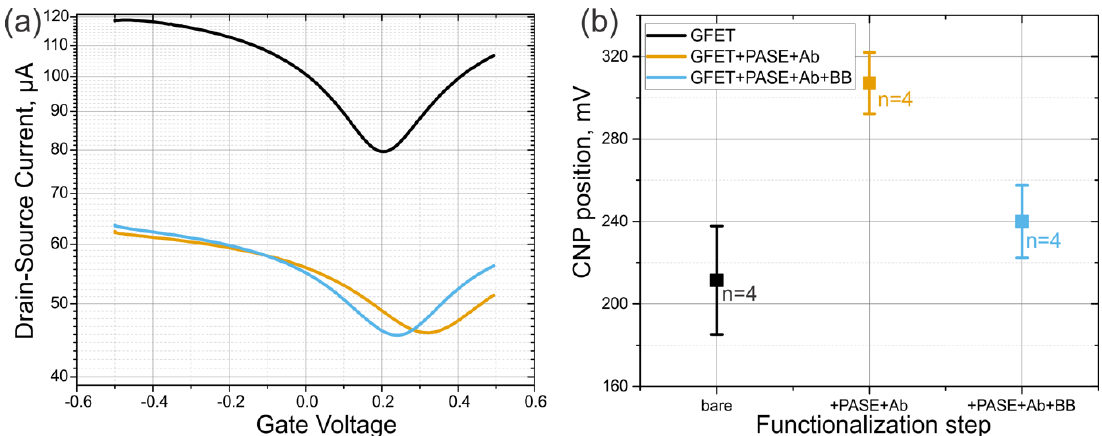
Figure 2. ( a ) Transfer curves of a GFET upon functionalization process. Black, orange, and blue lines represent the bare GFET, the GFET functionalized with PASE and antibodies, and the functionalized GFET after passivation with blocking buffer (BB). ( b ) Statistics of the CNP shift upon the same functionalization steps from n = 4 similar devices.